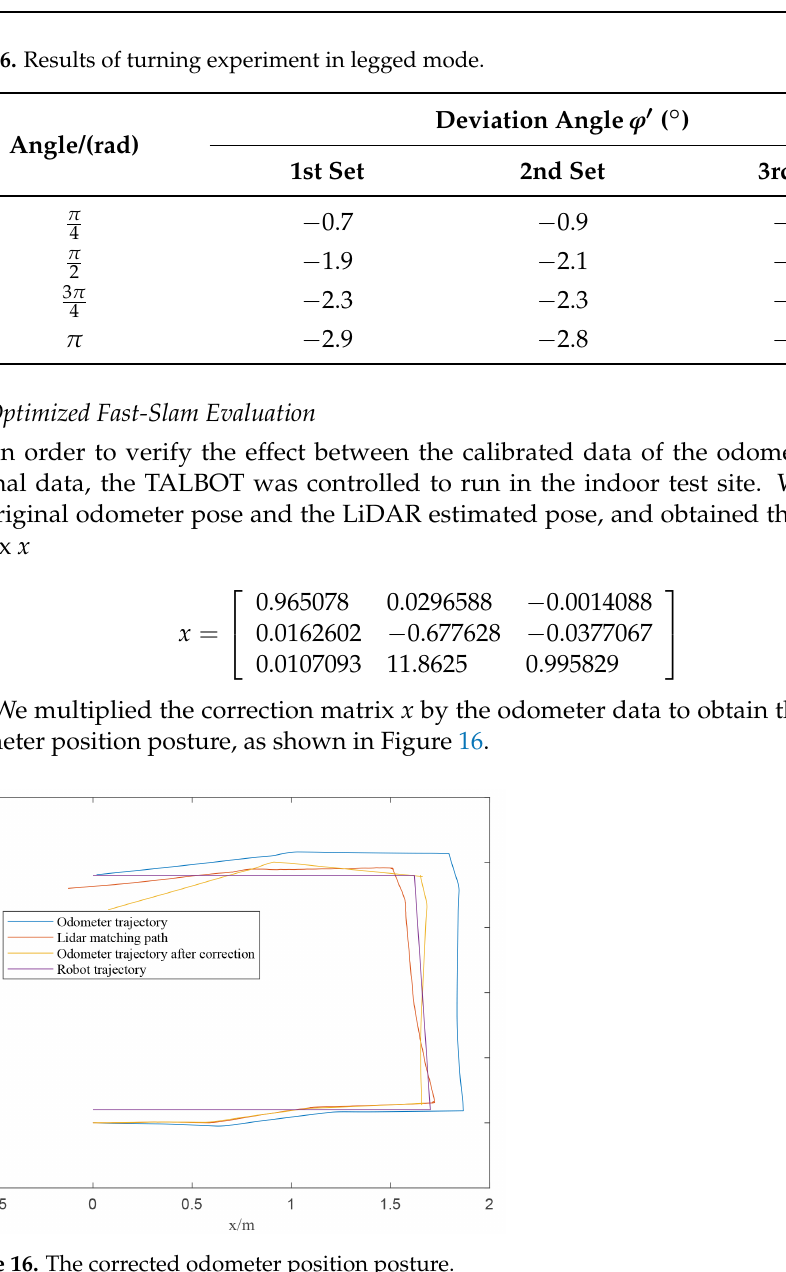
Figure 16. The corrected odometer position